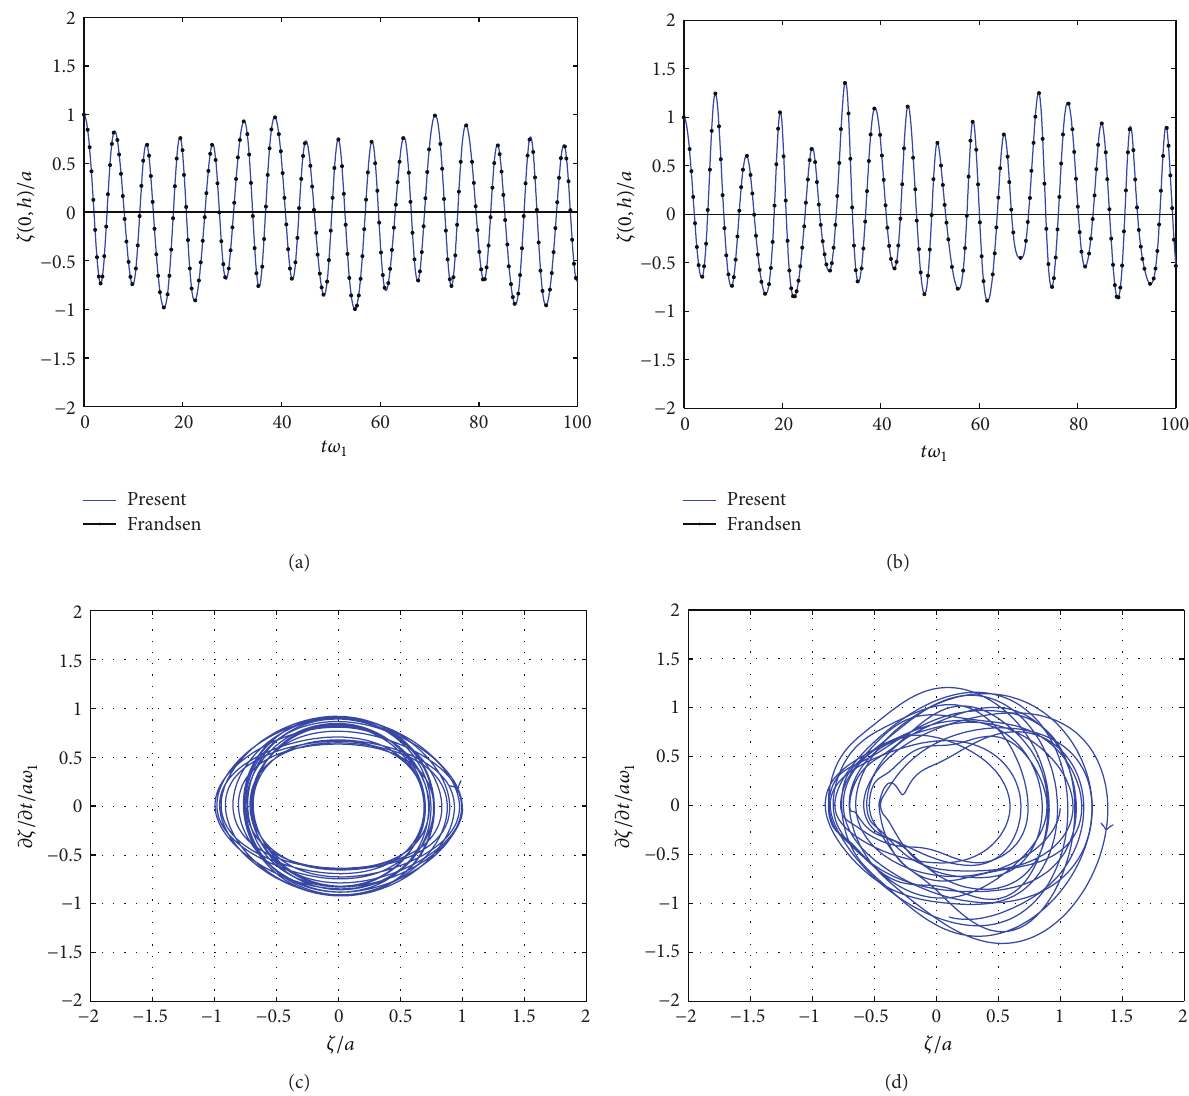
Figure 5: Free-surface elevation on the left wall in the stable region (test case 1): Ω 1 = 1.253 , 𝑘 V = 0.5 for (a) 𝜀 = 0.0014 , (b) 𝜀 = 0.288 , and the respective phase-plane